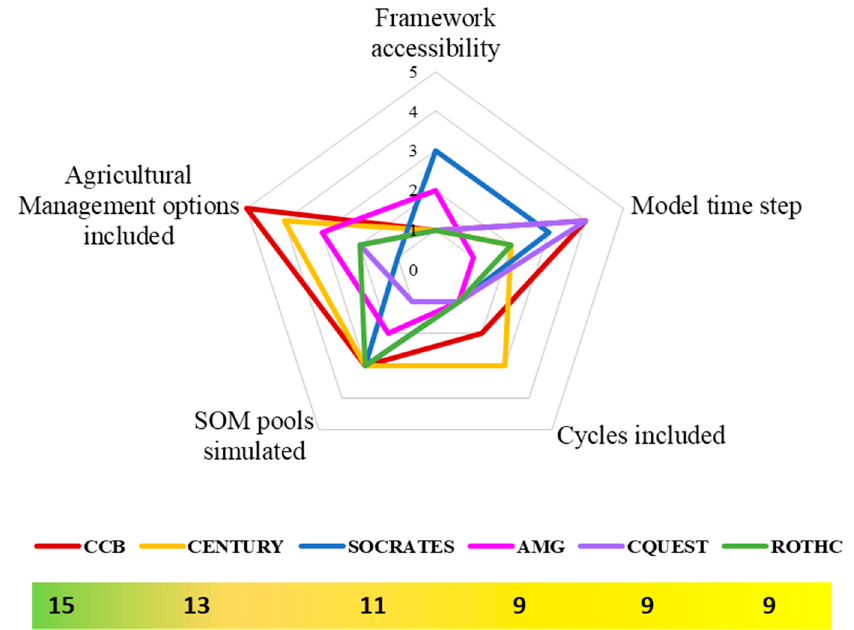
Figure 1. Scores obtained for each characteristic from each framework. The summed scores are presented below, from green (highest) to yellow (lowest).